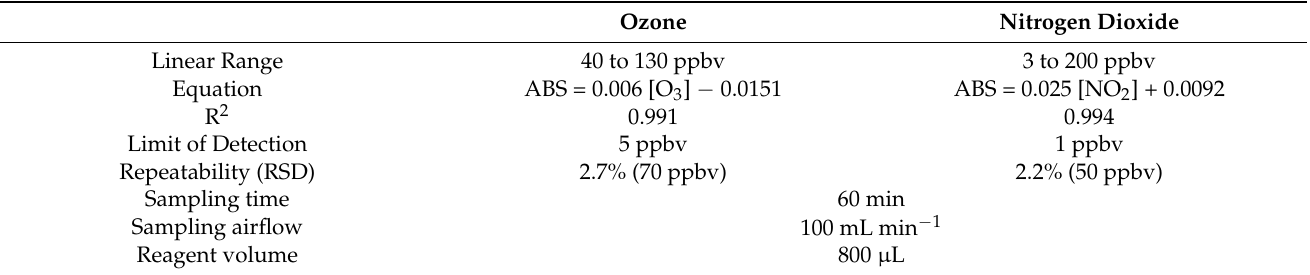
Table 2. Analytical parameters and optimized conditions of the proposed analytical platform for O 3 and NO 2 quantification.